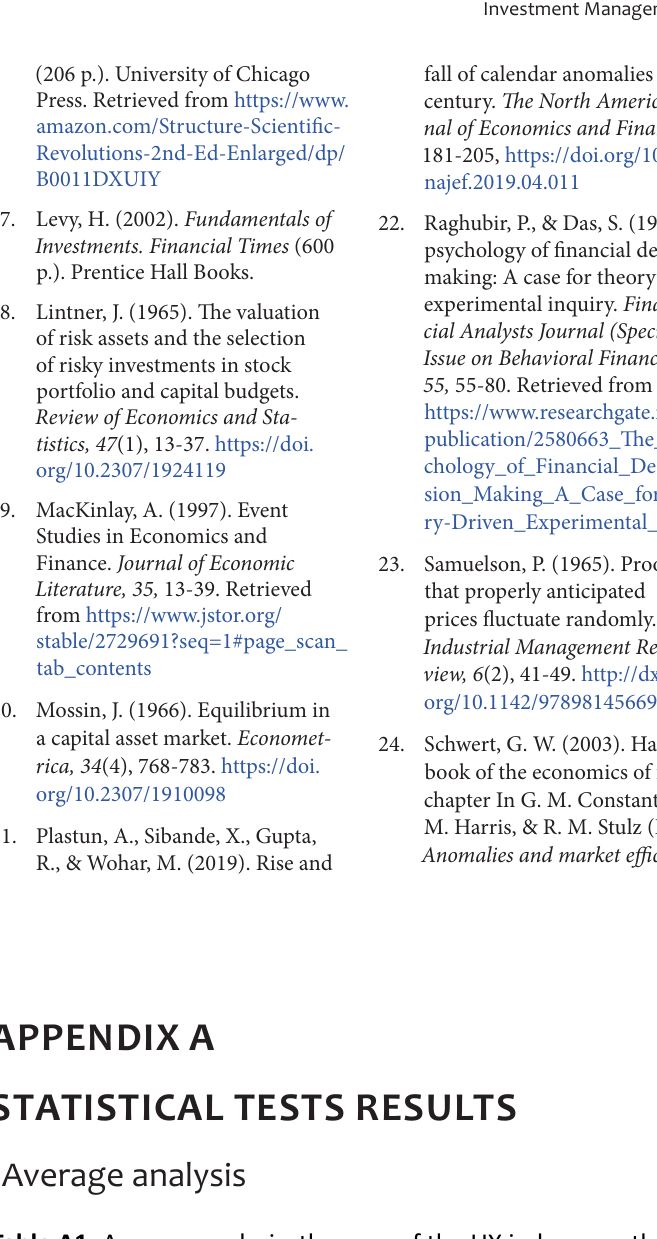
Table A1. Average analysis, the case of the UX index over the period 2009–2018 Parameter